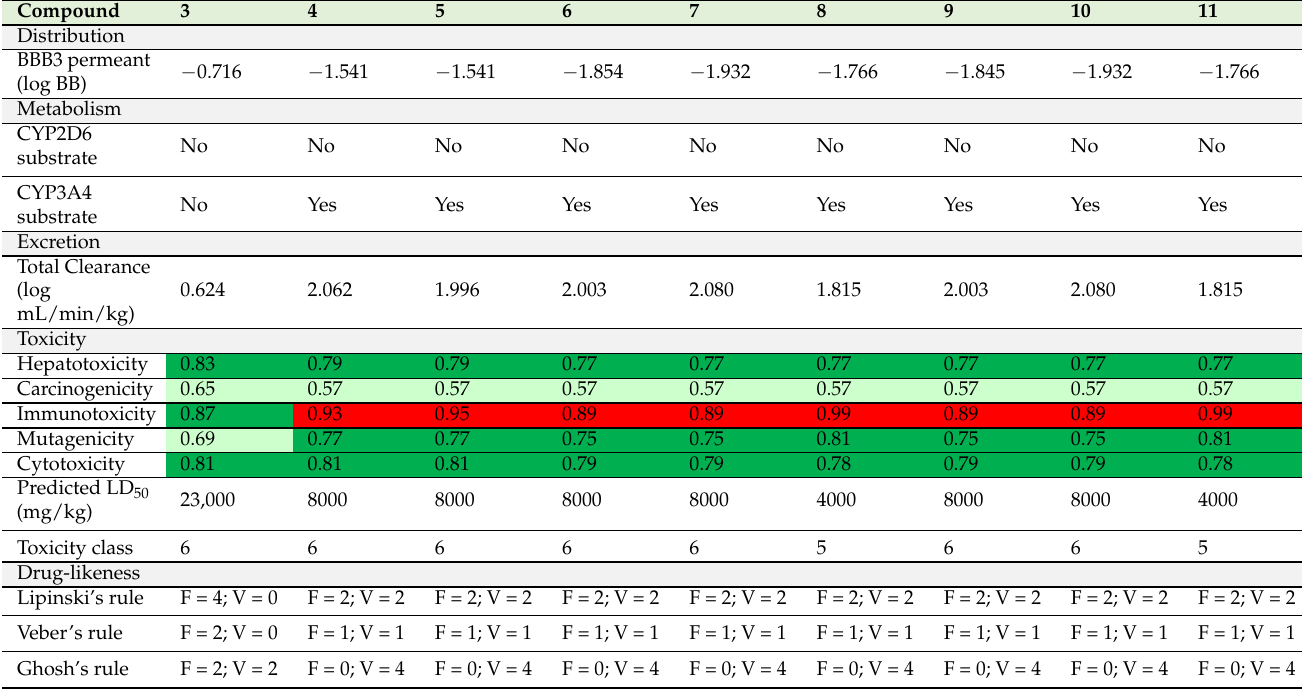
safer (shown in green and paste color) with respect to drug-induced hepatotoxicity (a